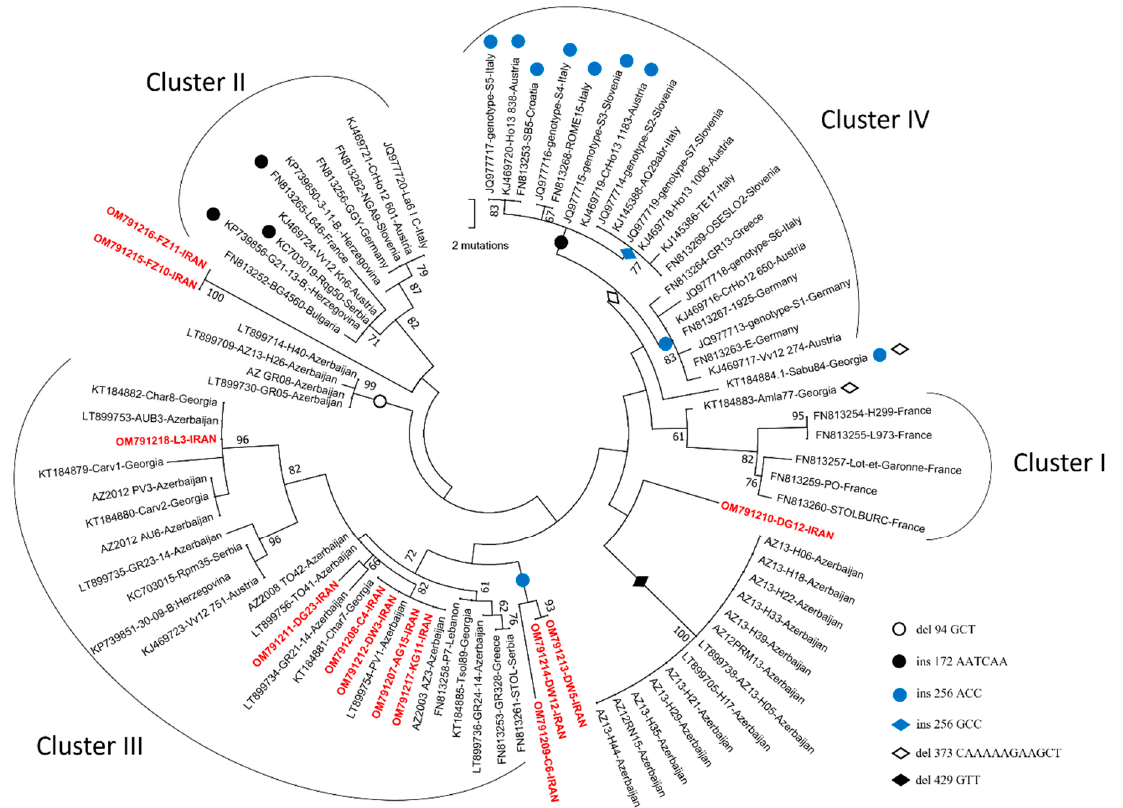
Figure 2. Phylogenetic analysis of the stamp sequences using maximum parsimony. Iranian ‘ Candidatus Phytoplasma solani’ isolates are indicated in red. The most parsimonious tree is shown with the bootstrap values indicated along the branches. Insertions and deletions (see Key, bottom right) for the isolates or phylogenetic branches are indicated at the top of the isolate names or along the branches. The stamp genetic clusters are those described in Fabre et al. [42].